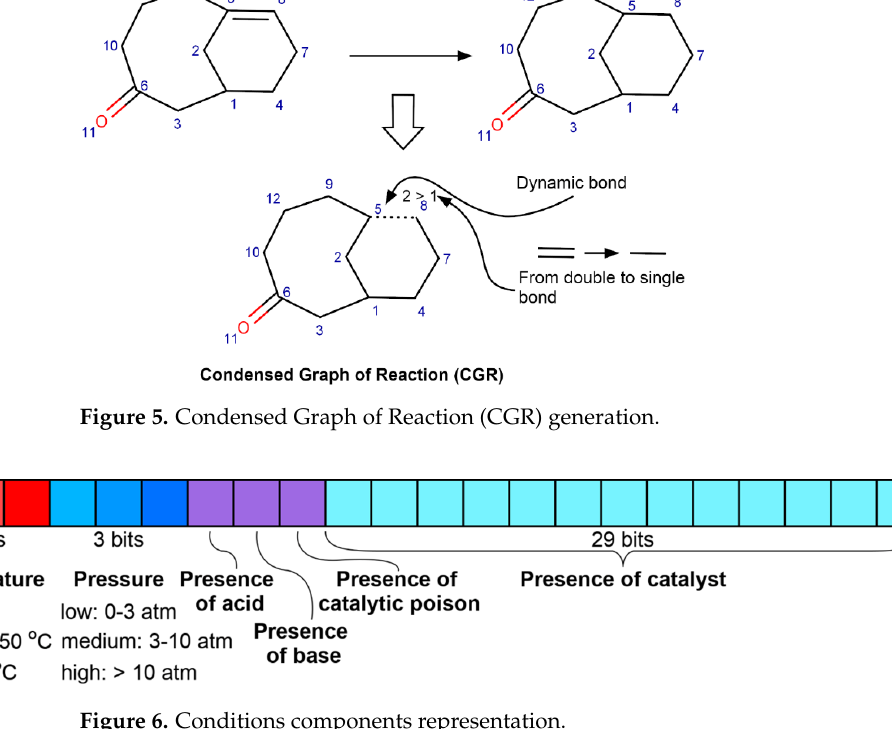
Figure 6. Conditions components representation.